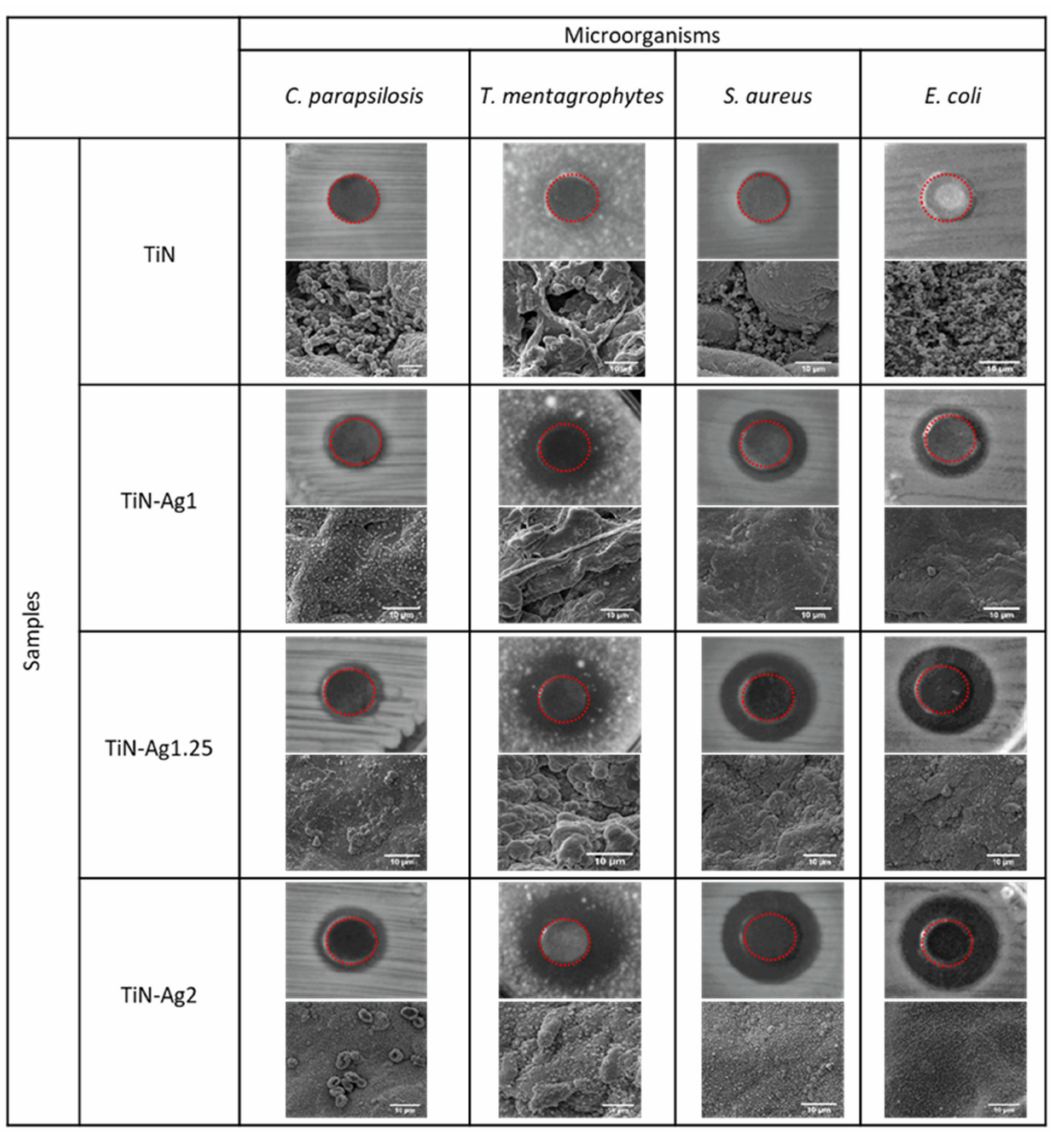
Figure 6. Antimicrobial activity of different samples: TiN, TiN-Ag1, TiN-Ag1.25 and TiN-Ag2 against C. parapsilosis , T. mentgrophytes , S. aureus and E. coli , evaluated by zone of inhibition assays and SEM images of the samples after the halo test. Red dashed circles highlight samples.